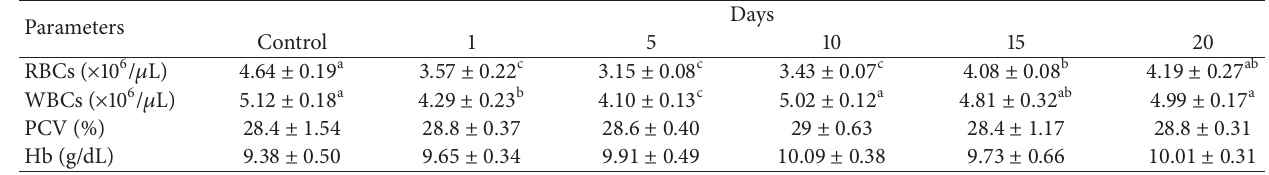
Table 2: Effect of repeated oral administration of 25mg/kg BW of tilmicosin daily for 5 consecutive days on some hematological parameters in broiler chicken ( 𝑛 = 5 ).